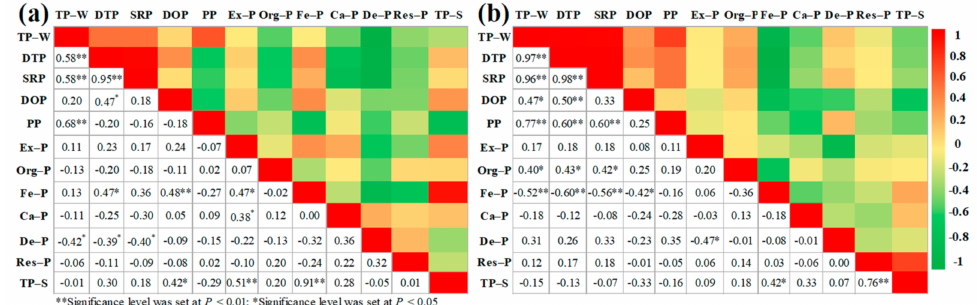
Figure 5. Correlation analysis of different phosphorus fractions in water–sediment phases in the wet season ( a ) and dry season ( b ) in the Tuojiang